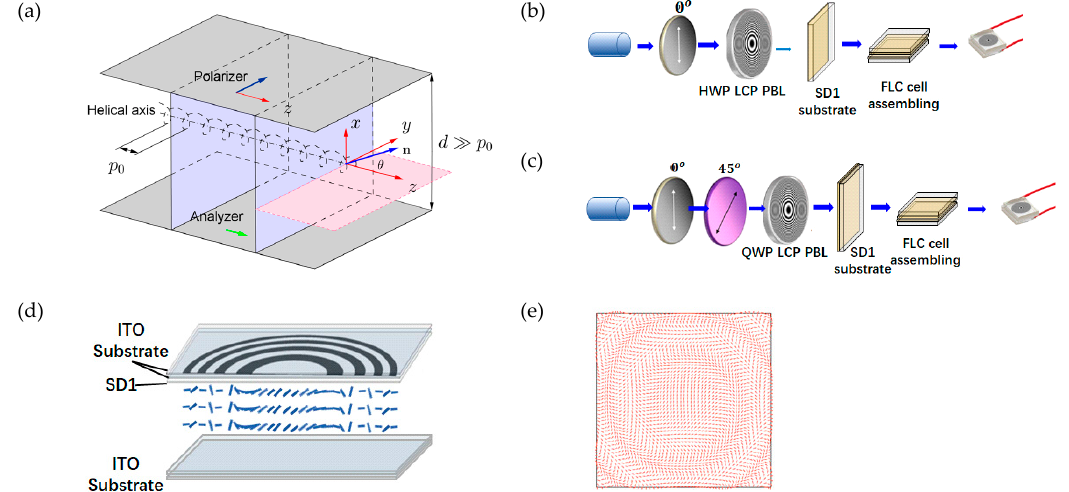
Figure 9. ( a ) Geometry of the DHFLC cell [27]. Experimental setups for obtaining ( b ) small F -number switchable FLC PBL cells, ( c ) the same F -number switchable FLC PBL cells. ( d ) Configuration of the FLC PBL in the absence of the electric field. (e) Illustration of the optical axis distribution.